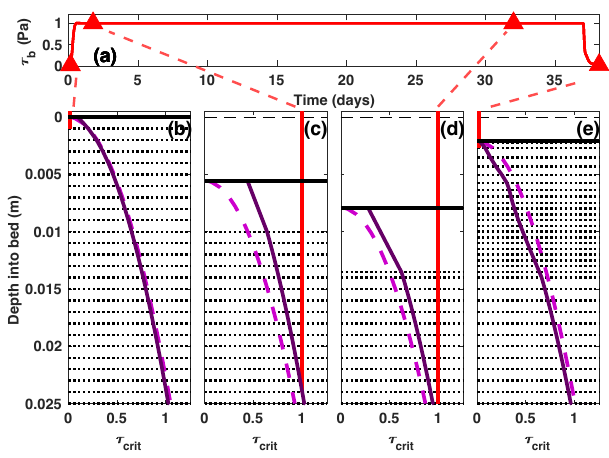
Figure 6. Time series of bottom stress (a) and profiles of critical shear stress for erosion during four distinct conditions: (b) initial bed condition; (c) eroded bed (after 1.3 days with τ b = 1 . 0Pa); (d) after slow but continuous erosion and reduced bulk critical stress profile due to swelling after 30 days more with τ b = 1 . 0Pa; and (e) rapid deposition after a day of low stress with τ b = 0 . 1Pa. In the lower panels, the solid red line is the magnitude of the bottom stress ( τ b ), the dashed magenta line is the equilibrium profile of bulk critical stress for erosion τ cb (z) , and the solid purple line is the in- stantaneous profile of bulk critical stress for erosion. The solid black line is the instantaneous position of the top of the bed at each time, with the initial bed elevation starting at